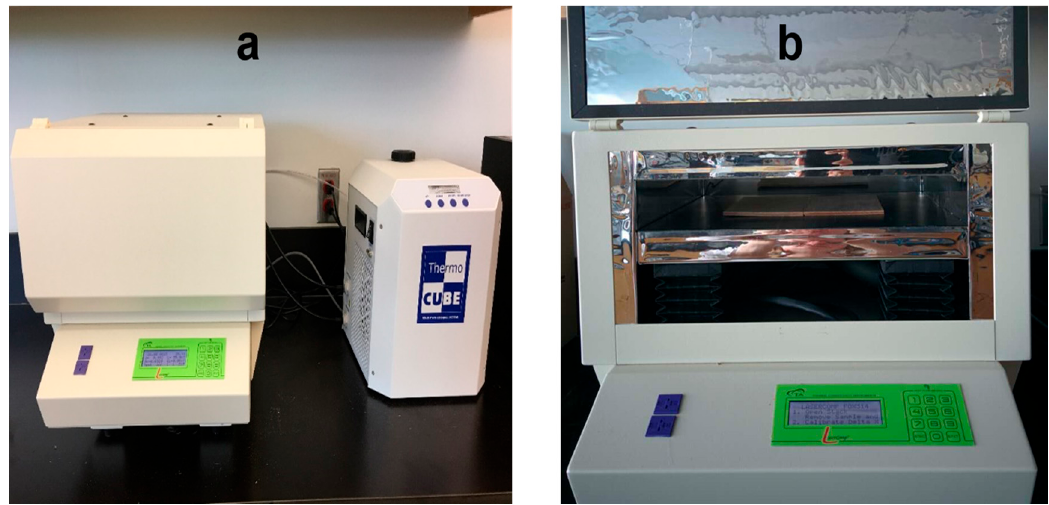
Figure 4. ( a ) Thermal conductivity testing apparatus; ( b ) Position of the sample and two heating